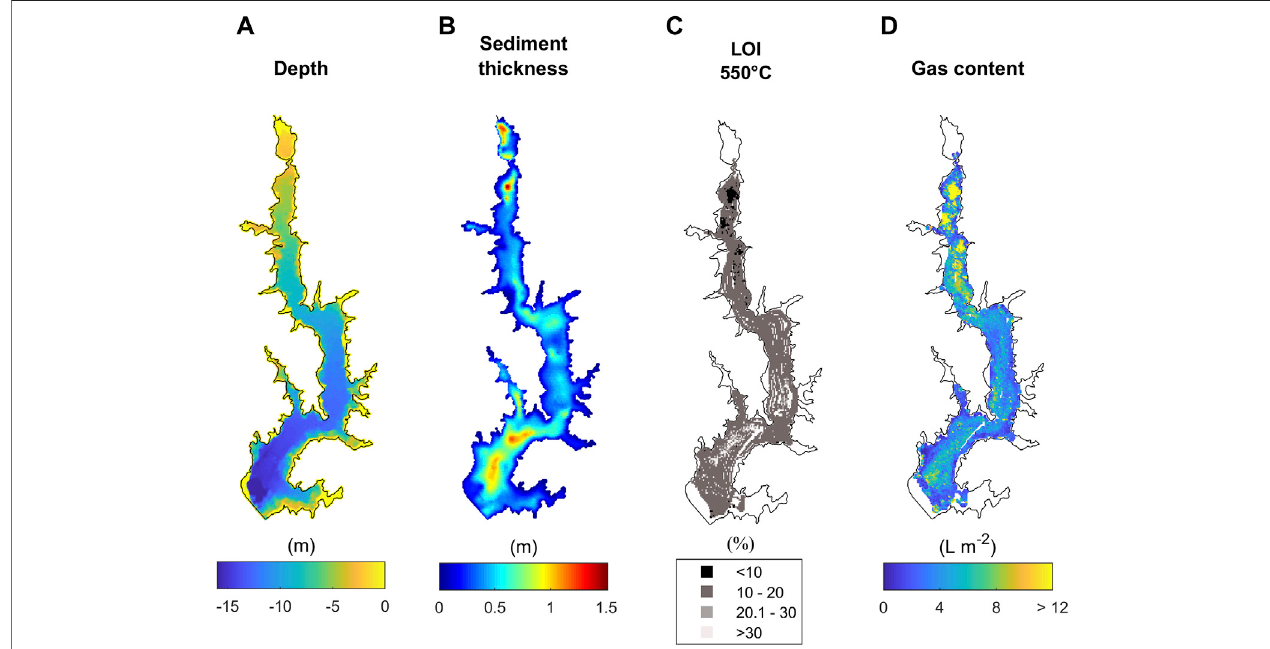
FIGURE 4 | (A) Passaúna Reservoir water depth and (B) sediment thickness distribution from Sotiri et al. (2021). (C) LOI 550 ° C extrapolated to the entire reservoir as a function of the acoustic parameter Attack with the relation proposed by Sotiri (2020). (D) Distribution of estimated gas content in the sediment estimated from the equation proposed by Anderson and Martinez (2015). All data are averaged for individual cells of the analysis grid. Blank areas in (C) and (D) indicate missing data and grid cells with high bottom slope ( > 10 °